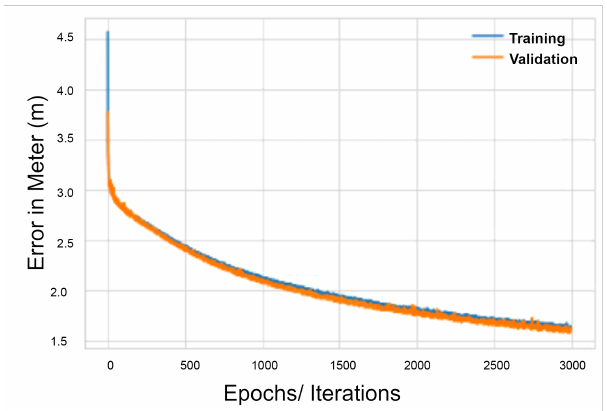
Figure 12. δ 1 Model mean Euclidean distance error in meter (m) vs. the number of Epochs.